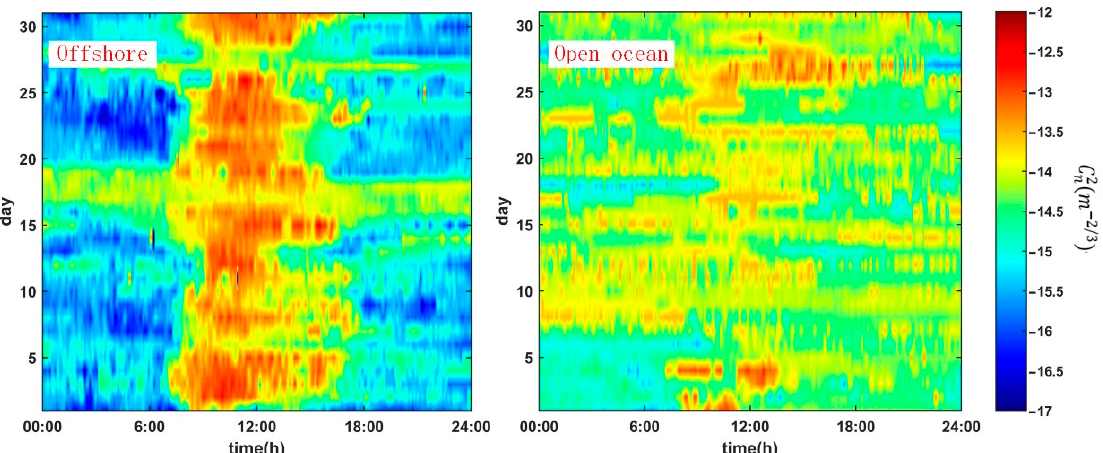
Figure 2. Distribution of diurnal curve of C 2 n over the offshore and open ocean